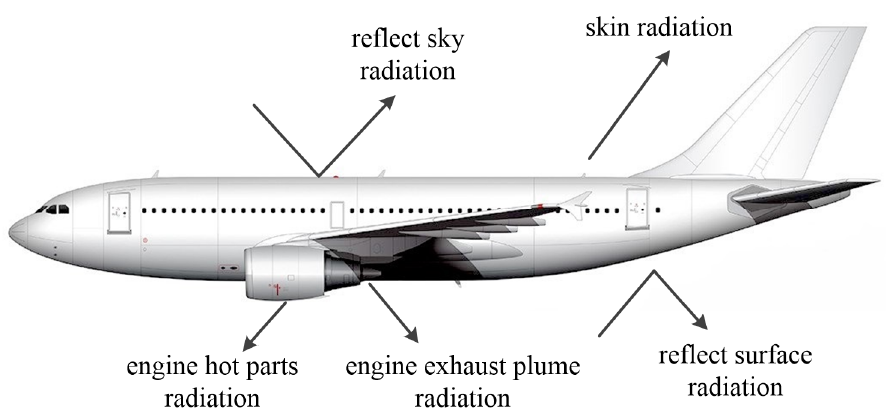
Figure 1. Distribution of infrared radiation sources of civil aircraft flying at high speed in the air. The high-altitude aircraft target can be regarded as flying parallel to the ground; along the side observation direction of the infrared camera, the high-temperature gas at the tail of the aircraft is blocked to a certain extent. Thus, for the various thermal radiations of the aircraft itself, the skin radiation of the engine hot parts and the skin radiation of the aircraft fuselage will be focused on in the observation. The ground radiation is mostly dominated by long-wave radiation, and the solid angle of the ground radiation received by the side of the aircraft is small so that the skin radiation of the aircraft itself is much larger than the ground object radiation reflected by the aircraft [16]. The atmospheric radiation reflected by the aircraft has a low emissivity and a small amount of radiation, which is lower than that of the aircraft skin itself [17]. In short, the skin radiation can be approximated as the skin’s own thermal